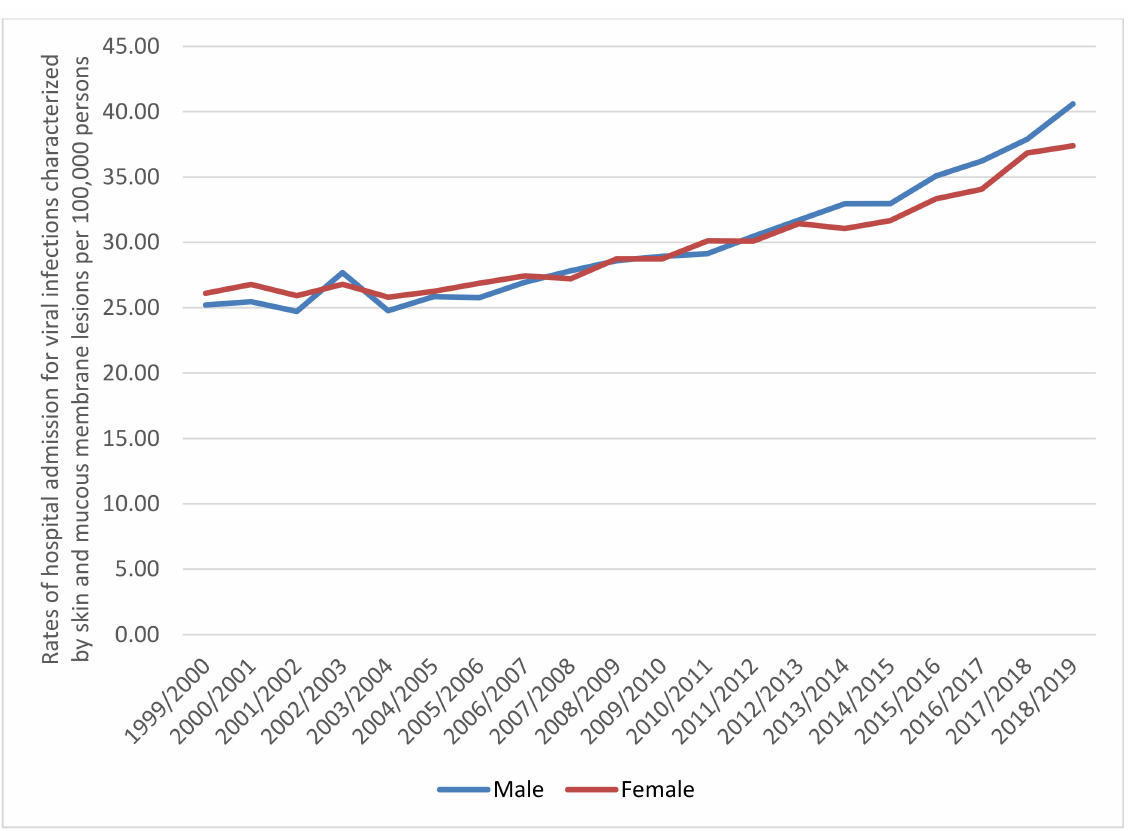
Figure 3. Rates of hospital admission in England and Wales stratified by gender.